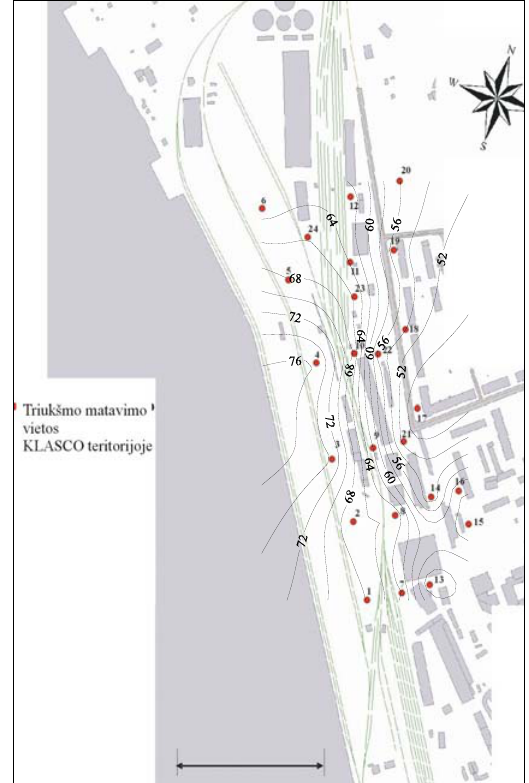
6 pav. Ekvivalentinio triukšmo lygio sklaida dienos metu rugpj ūč io m ė n. Fig 6. Dispersion of reciprocal noise level in the day in August Iš 6 pav. matyti, kad rugpj ūč io m ė nes į dienos metu ekvi-